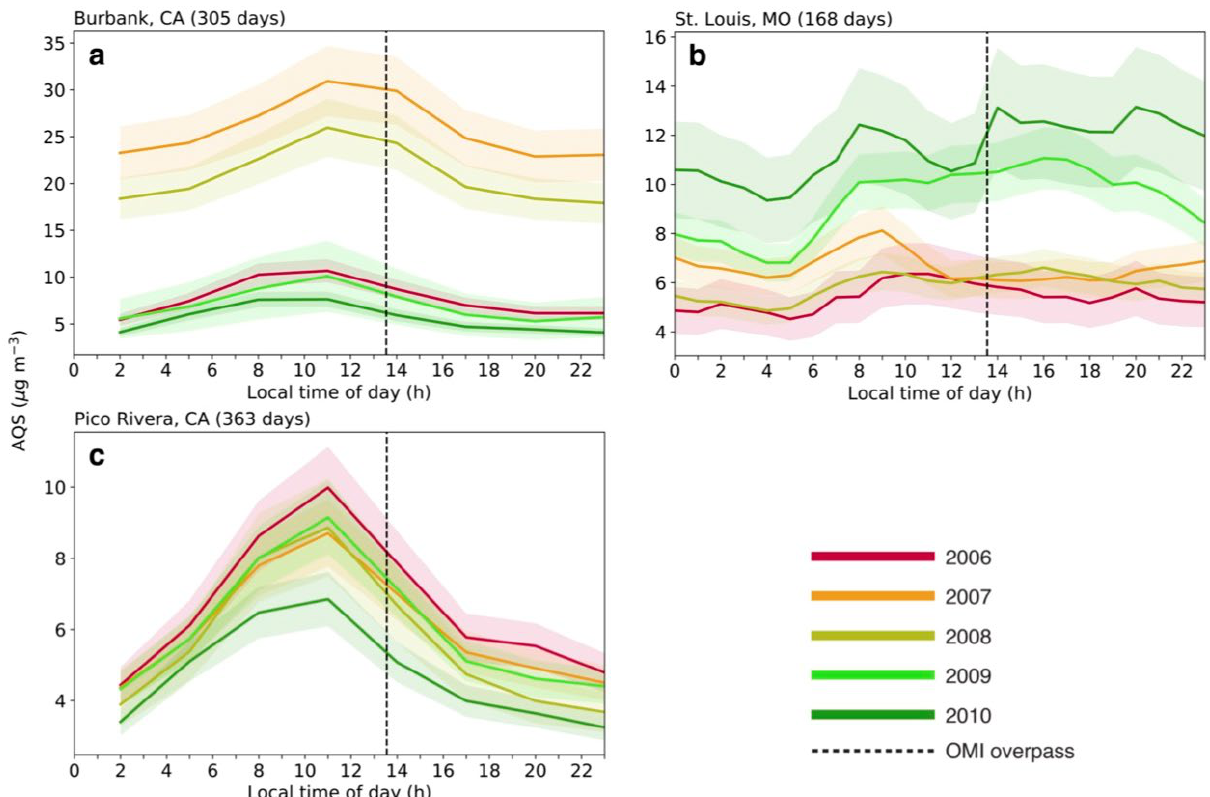
Figure 2. HCHO mixing ratios from ground-based AQS monitors at three sites (( a ): Burbank, CA; ( b ): St. Louis, MO; ( c ): Pico Rivera, CA) from 2006 to 2010. Solid lines show June, August, September (JAS) average diurnal cycle with complete measurements (24 measurements per day for 1 h site or 8 measurements per day for 3 h site). The shaded area indicates standard deviation in that averaging year. Different years are labeled in different colors, indicated in the bottom right. OMI overpass time (13:30 local time) is labeled with a vertical dashed line at each